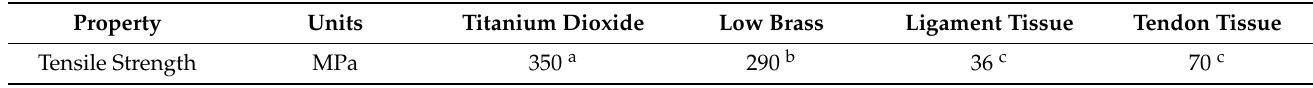
Table 1. Tensile Strengths of Titanium Dioxide, Low Brass, Ligament, and Tendon Tissues.